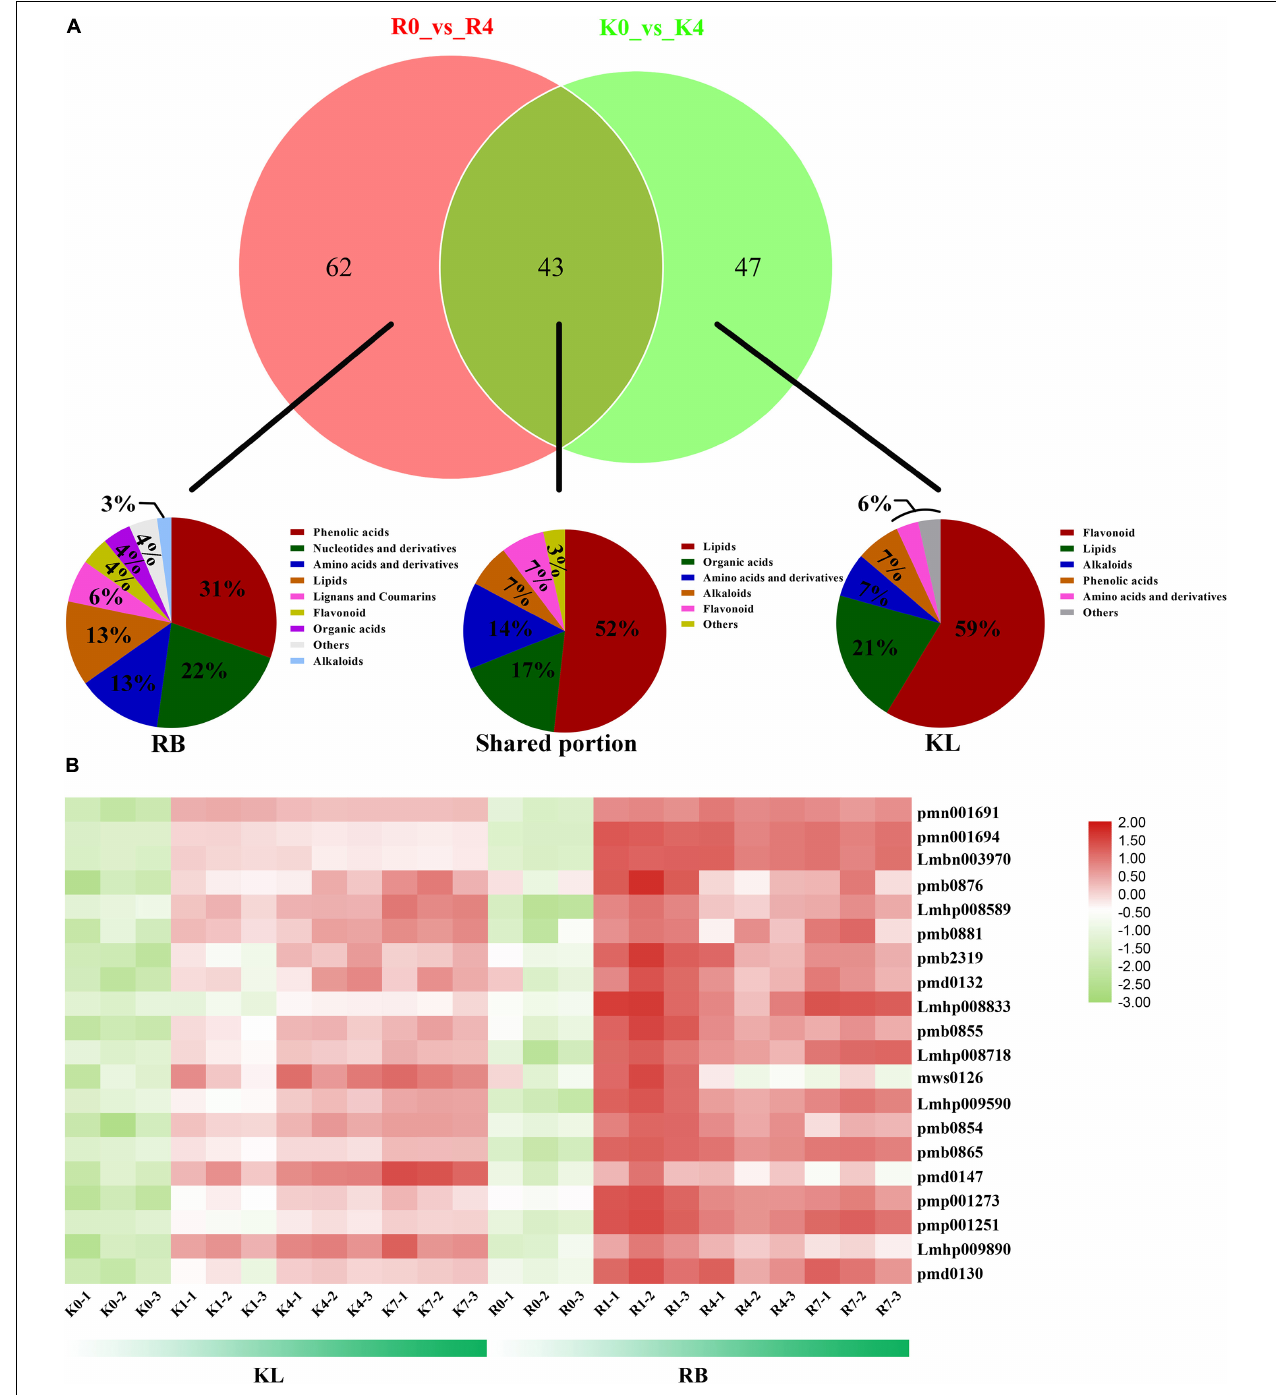
FIGURE 7 | Comparison of metabolites levels and lipids between KL and RB genotypes under − 4 h/ − 25 ◦ C treatment. (A) Venn diagrams of DEMs between both genotypes at the 4-h time point under − 25 ◦ C. Classification of their common (shared) metabolites and of those accumulated only in KL and those only in RB. (B) Heat map of metabolite lipids responsive to cold in both KL and